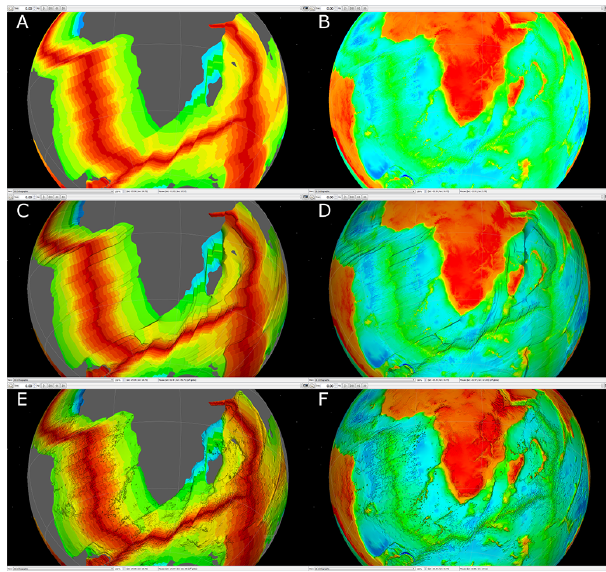
Figure 12. The left side shows the oceanic crustal age grid raster (Müller et al., 2008). The right side shows the General Bathymetric Chart of the Oceans (GEBCO) raster (Goodwillie, 2003). (A) age grid colour only; (B) GEBCO colour only; (C) age grid colour with age grid relief; (D) GEBCO colour with age grid relief; (E) age grid colour with GEBCO relief; (F) GEBCO colour with GEBCO